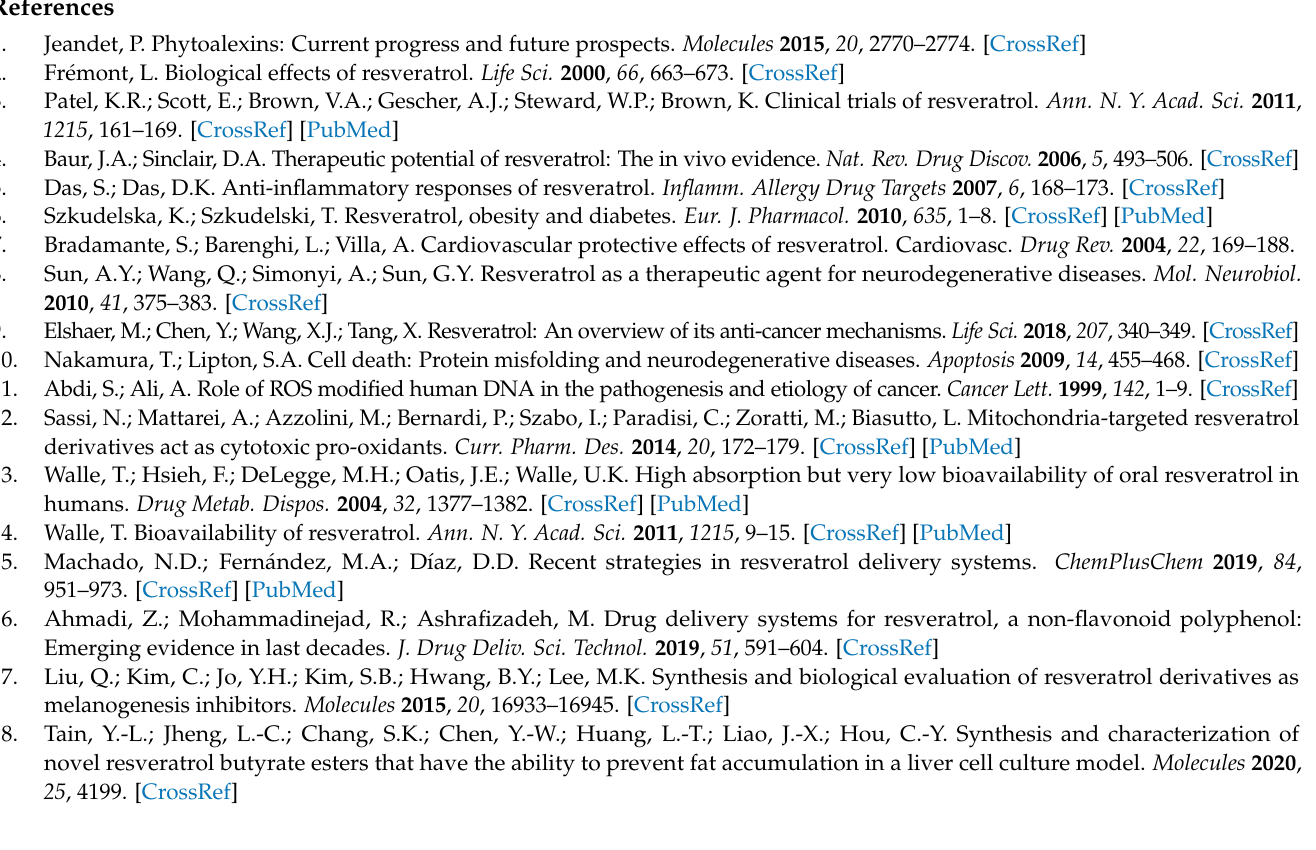
Supplementary Materials: Figure S1: MS results of resveratrol monolaurate in negative mode, Figure S2: Original result of 1 H-NMR of resveratrol, Figure S3: Original result of 1 H-NMR of resver- atrol monocaprylate, Figure S4: Original result of 1 H-NMR of resveratrol monocaprate, Figure S5: Original result of 1 H-NMR of resveratrol monocaproate, Figure S6: Original result of 1 H-NMR of resveratrol monobutyrate, Figure S7: Original result of 1 H-NMR of partially purified resveratrol